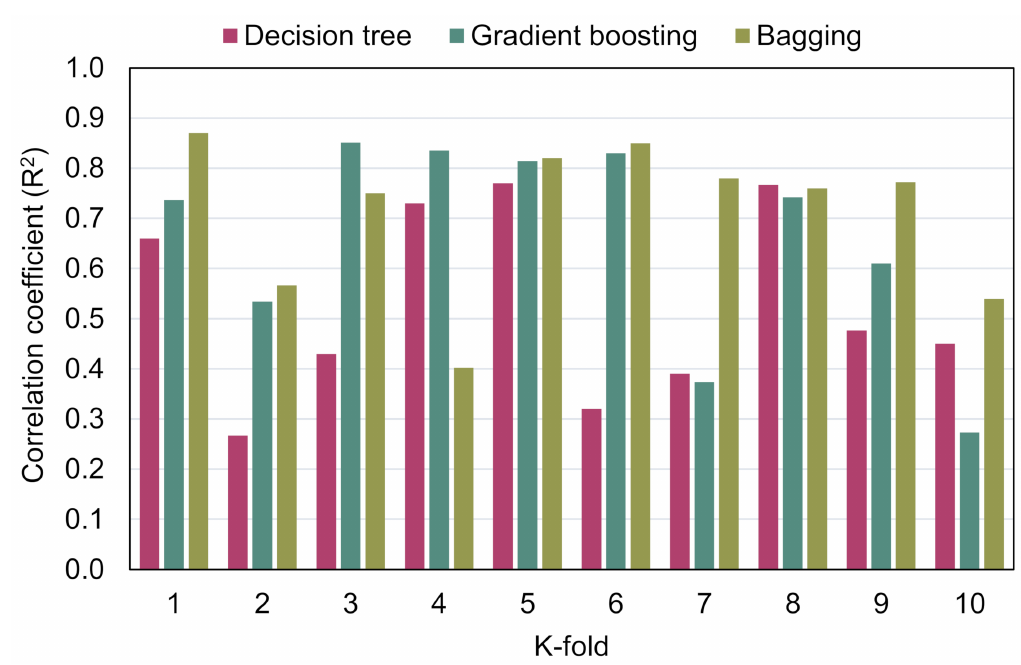
Figure 12. Correlation coefficient (R 2 ) distribution from the k-fold